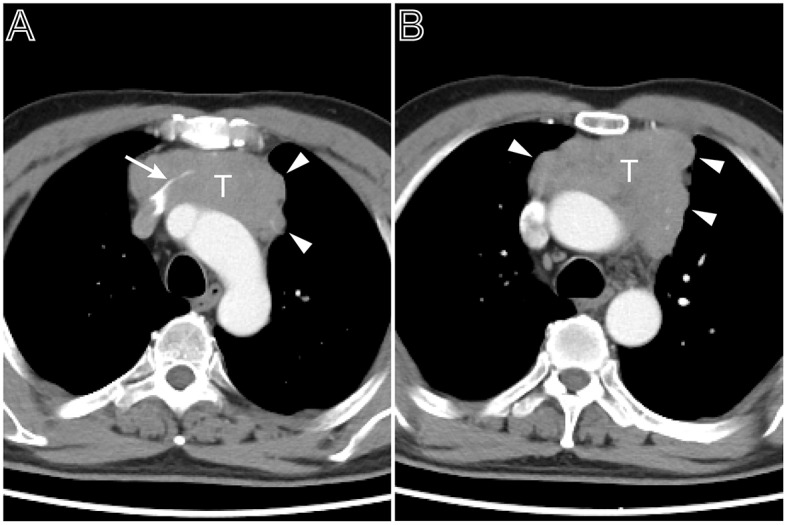
A multi-lobulated heterogeneous thymoma with vascular invasion. Axial contrast-enhanced chest CT image obtained at the level of the aortic arch demonstrated a thymoma in a 54-year-old man complained of bosom frowsty and chest pain (Masaoka–Koga stage III and WHO classification B1). The lesion directly invaded the left brachiocephalic vein (A, white arrow). The tumor showed the heterogeneous attenuation distributions and multi-lobulated contour (A,B, arrow head), the aortic arch was pushed backward.